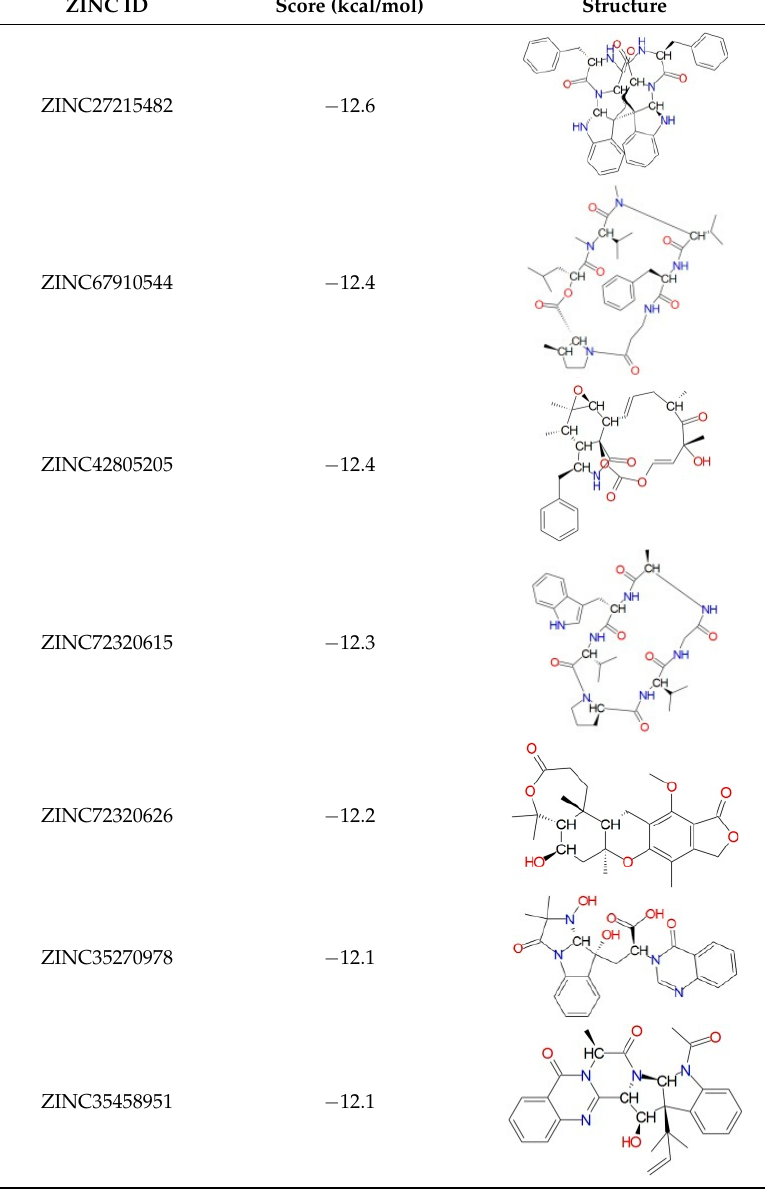
Table 3. Free energy of binding between BaThrRS and novel inhibitors.